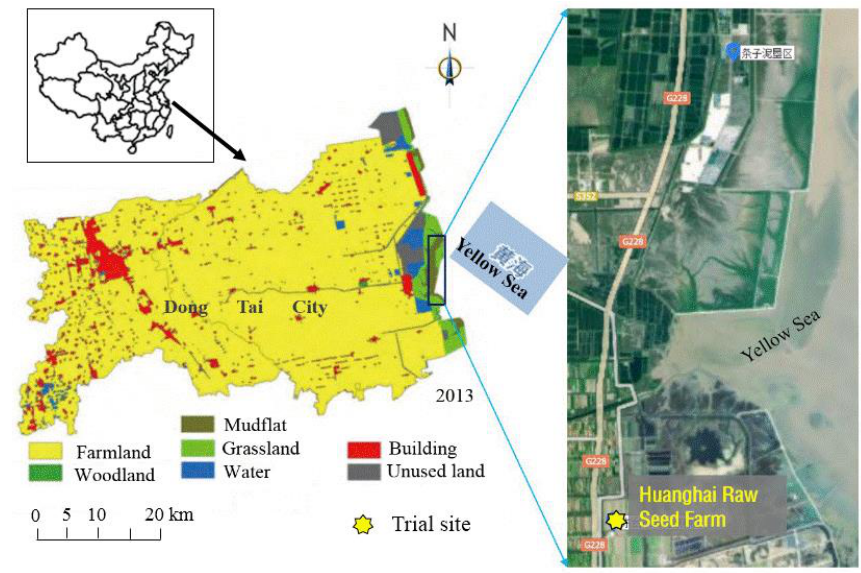
Figure 1. Location of study area. Table 1. Basic properties of the original topsoil (0 – 20 cm) and biochar used for the experiment. Sample pH H2O